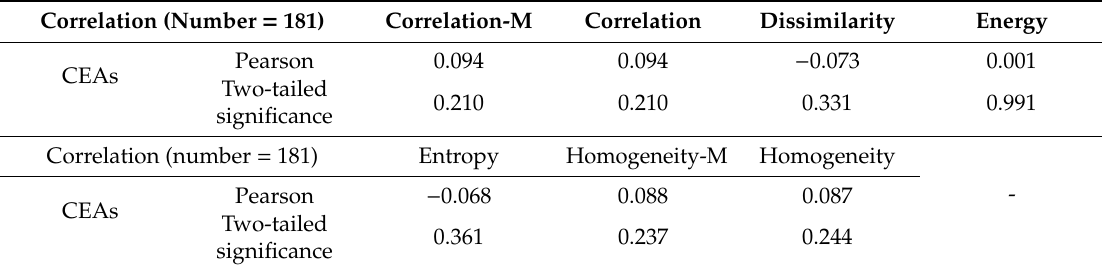
Table 1. Association between carcinoembryonic antigens (CEAs) and GLCMs texture features.